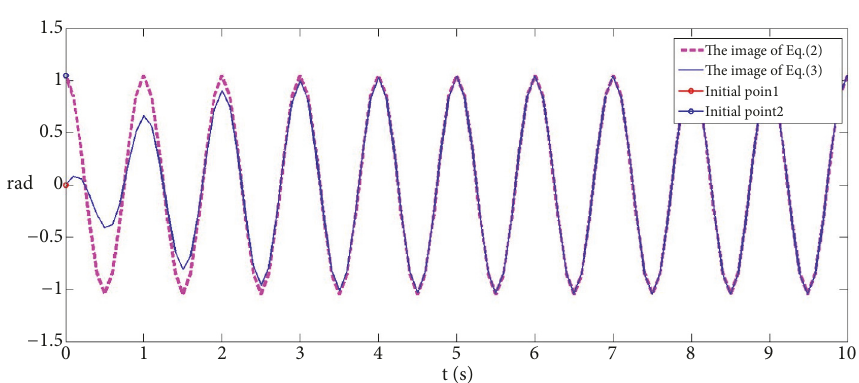
Figure 10: Contrast diagrams of the equations.